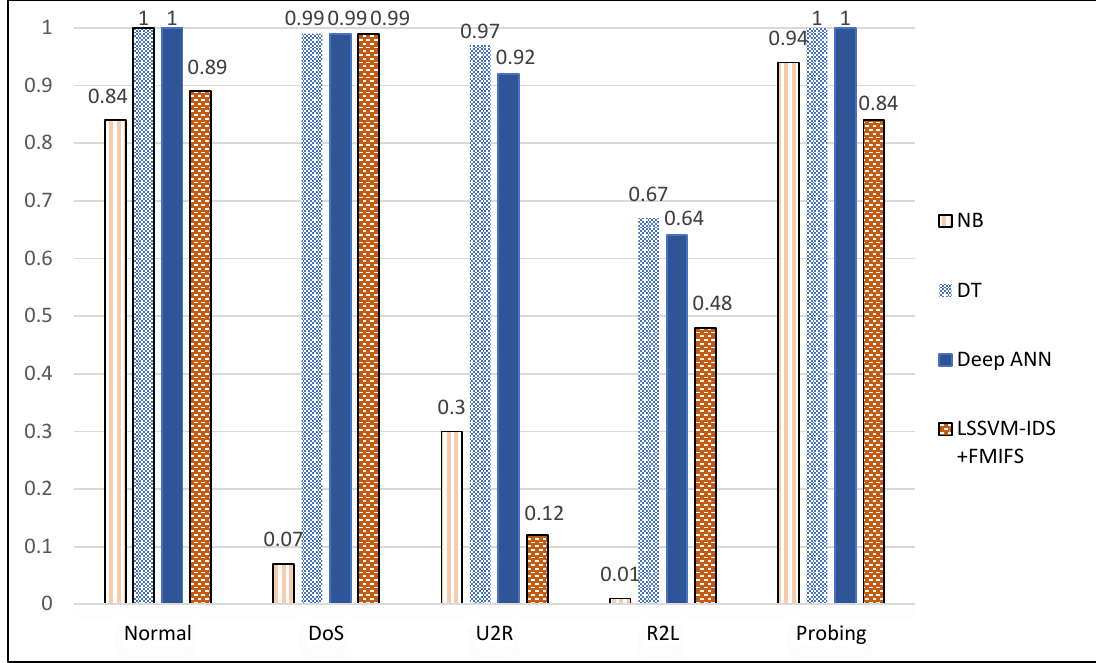
Figure 12. Anomaly detectors’ F-score.